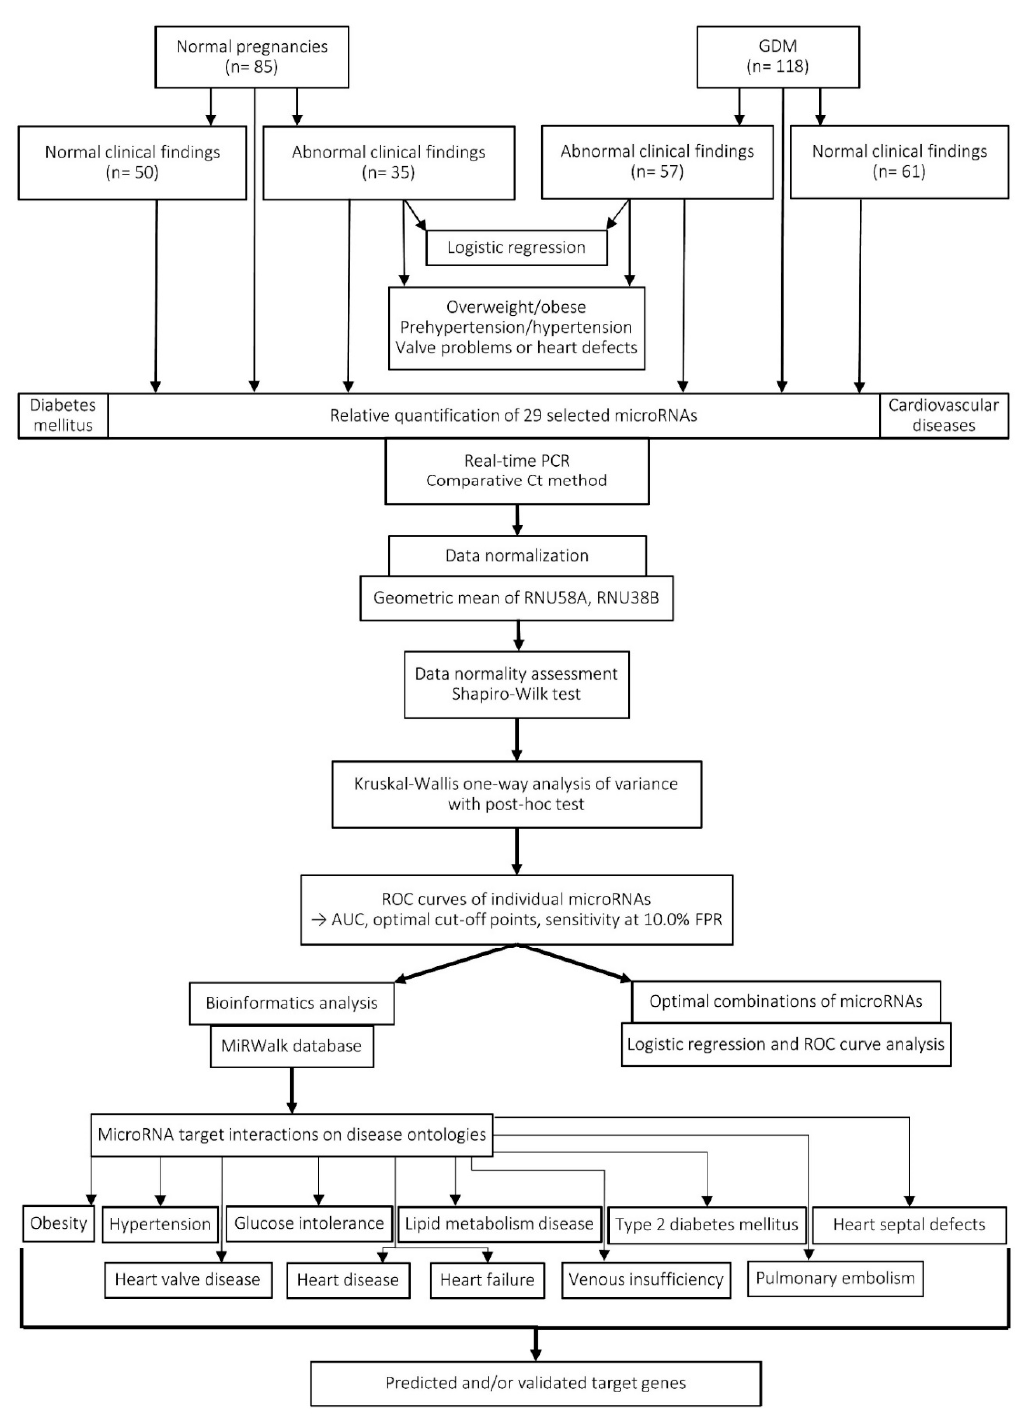
Figure 1. Workflow of the study.